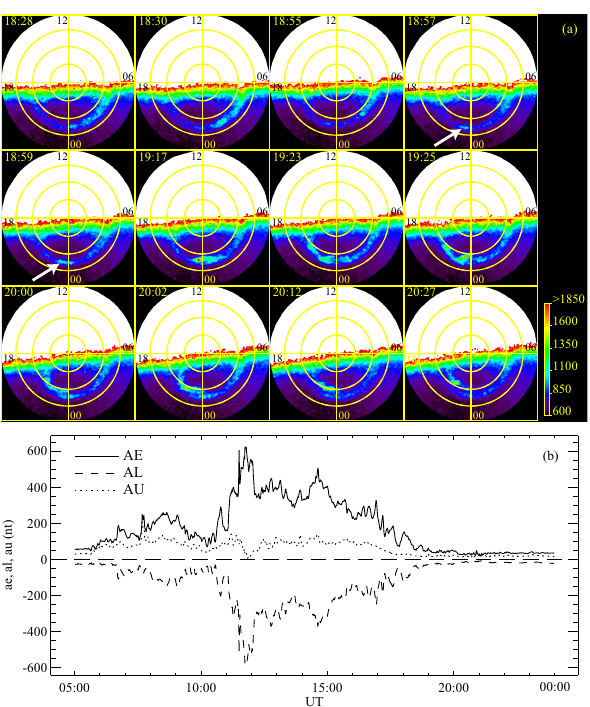
Fig. 1. (a) Polar view of the WIC count rate obtained on 22 Septem- ber 2001, in magnetic coordinates (noon at top, concentric circles every 10 Deg MLAT). The bright dayglow appears as white in the upper part of each image. The white arrows show the brightening at 18:57UT and its evolution at 18:59UT. (b) Auroral AE, AL and AU indices recorded on 22 September 2001.